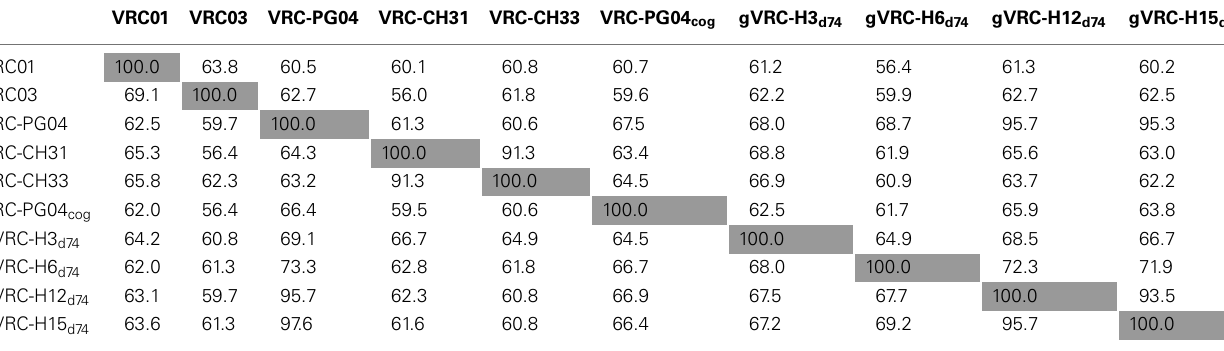
Table 1 | Percent sequence-identity matrix of 10 plasmid antibody heavy-chain variable domains tested by 454 pyrosequencing.